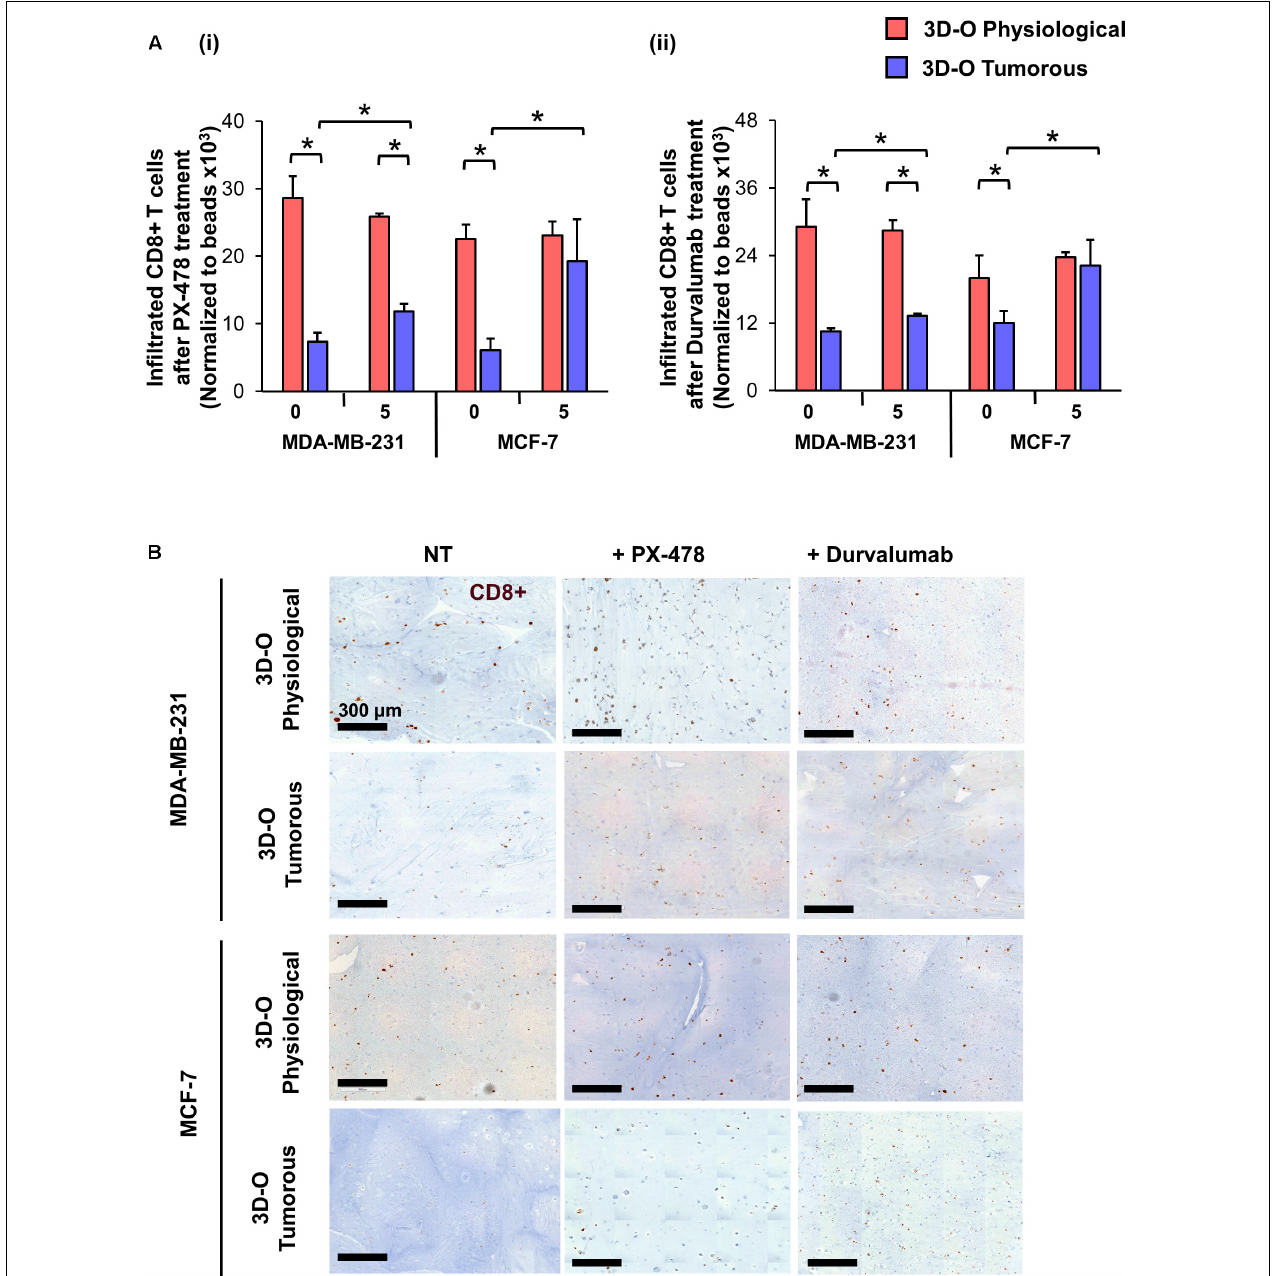
FIGURE 8 | Sensitization of BCa cells to cytotoxic CD8+ T cells within 3D-O matrices. (A) CD8+ infiltration into 3D-O physiological and 3D-O tumorous matrices seeded with MDA-MB-231 and MCF-7 cells on day 7 after treatment with PX-478 at 5 µ M concentration (i) and Durvalumab at 5 µ M concentration (ii) for the first 4 days. (B) Representative IHC results representing CD8+ infiltration into 3D-physiological and 3D-tumorous scaffolds seeded with MDA-MB-231 and MCF-7 cells on day 7 after treatment with PX-478 and Durvalumab, Scale bar = 300 µ m. * p < 0.05, (n.s.) not significant, data were analyzed using unpaired two-tailed Student’s t